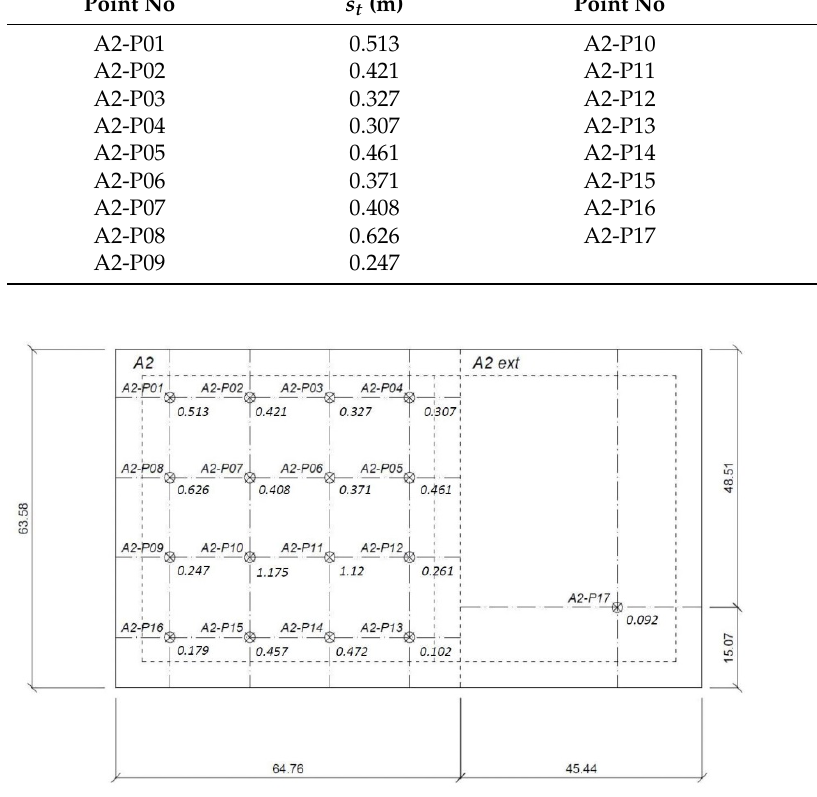
Figure 16. The embankment with marked settlement in measurement points from A2-P01 to A2- P17.